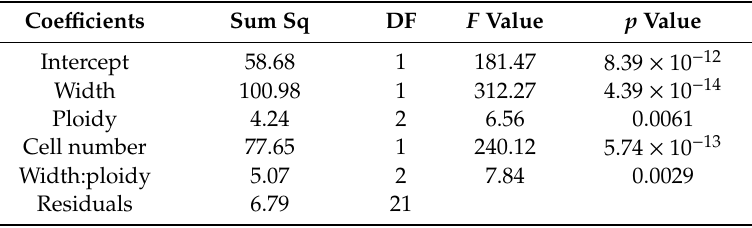
Table 4. ANOVA results for corolla tube circumference~width + ploidy + width: ploidy + cell number.